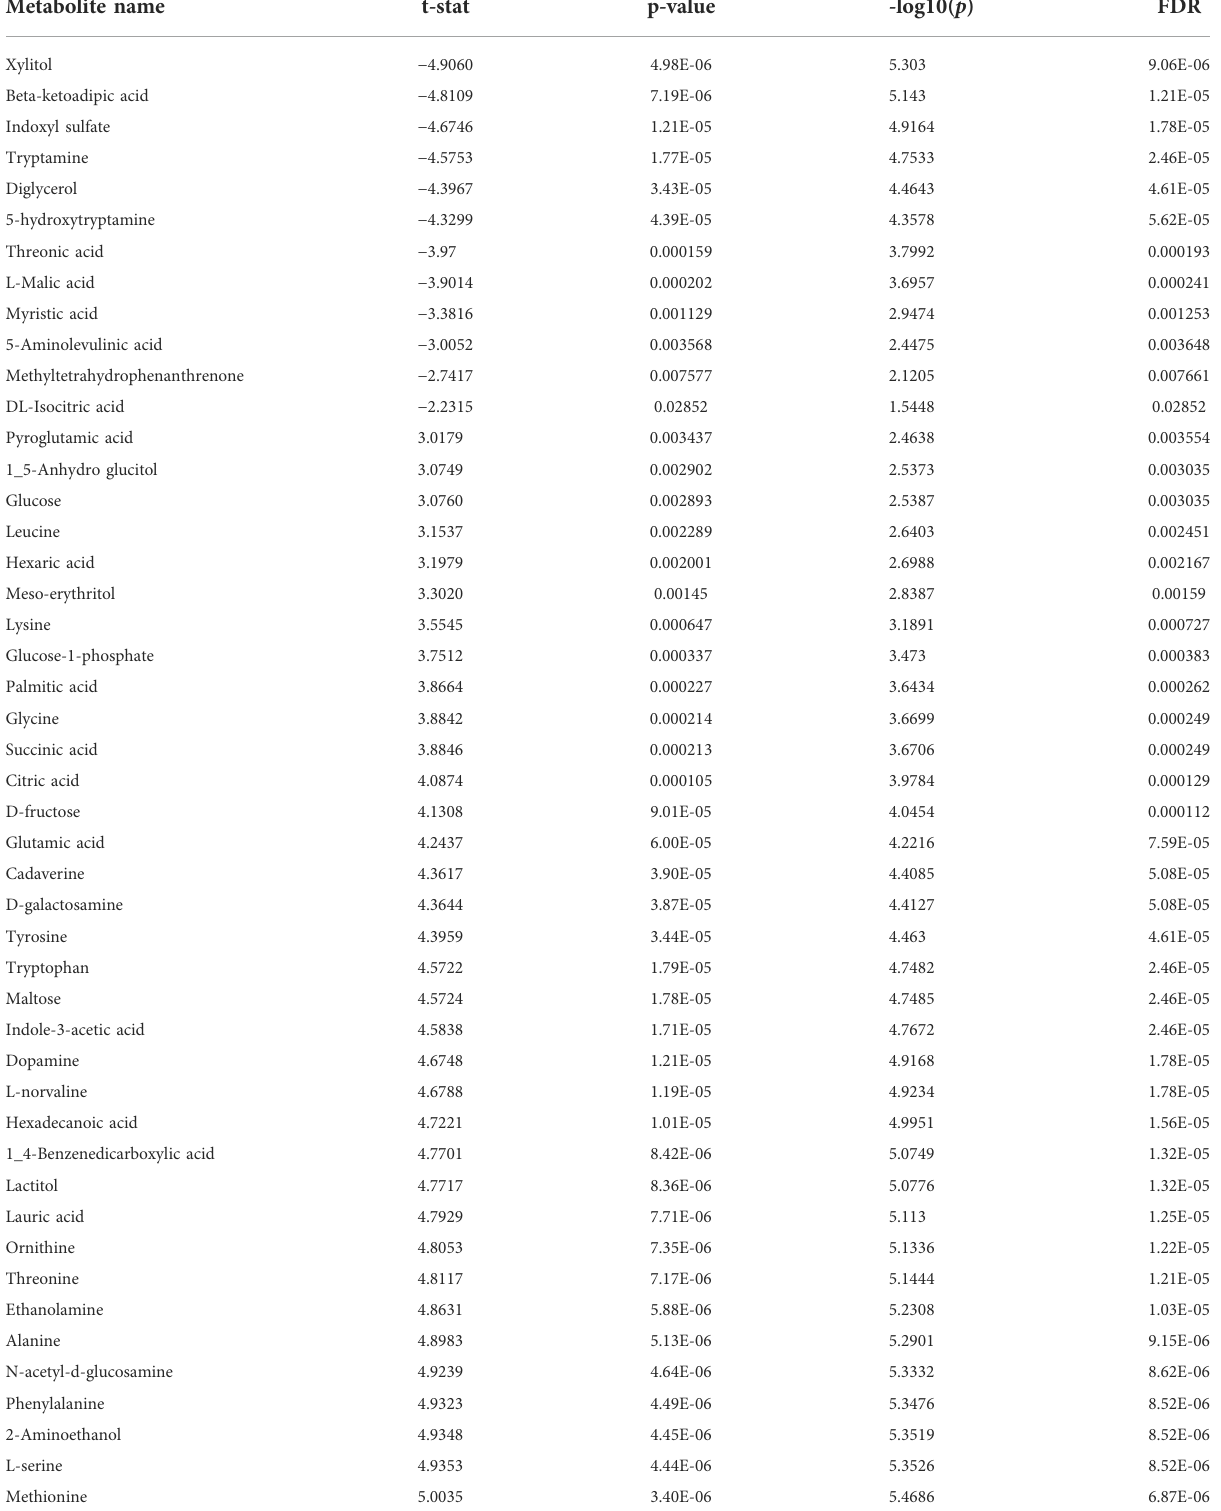
TABLE 2 Signi fi cantly different metabolites obtained through Student ’ s t-test (nominal p -value ≤ 0.05; FDR cut-off < 0.05), altered by OSA. Positive t-stat indicates down-accumulated metabolites, whereas negative t-stat indicates up-accumulated